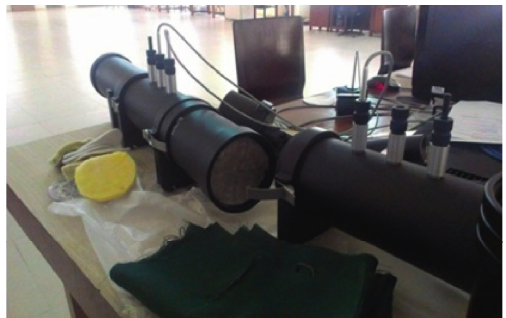
Figure 4: Impedance tube measurement